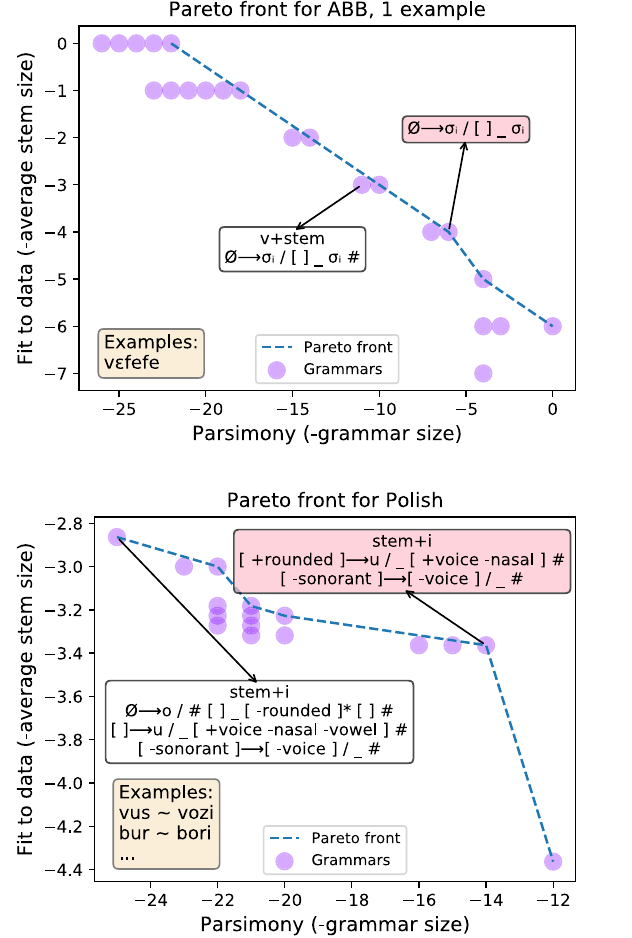
and y axes have different scalesineach panel. Pink shade:correct grammar. Asthe number of examples increases, the Pareto fronts develop a sharp kink around the correct grammar, which indicates a stronger preference for the correct grammar. With one example the kinks can still exist but are less pronounced. The blue lines provably show the exact contour of the Pareto frontier, up to the bound on the number of rules. This precision is owed to our use of exact constraint solvers. We showthePolishproblembecausethetextbookauthoraccidentallychosedatawith an unintended extra pattern: all stems vowels are /o/ or /u/, which the upper left solutionencodesviaaninsertionrule.Althoughthe PolishMAPsolutioniscorrect, the Pareto frontier can reveal other possible analyses such as this one, thereby serving as a kind of linguistic debugging. Source data are provided as a Source data fi